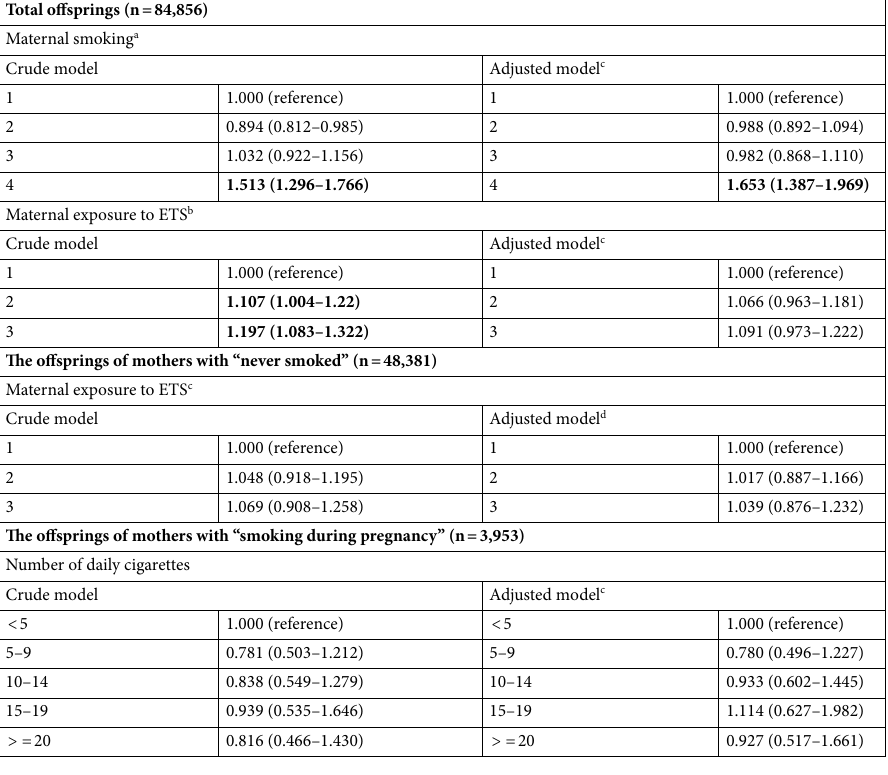
Table 2. Binominal logistic regression analysis of maternal smoking and maternal exposure to ETS for predicting offspring’s smaller circumference. Binominal logistic regression analysis was constructed to evaluate parental smoking for predicting their offspring’s smaller head circumference (HC) (small HC was defined as less than three percentile for their gestational age and sex) in the total offsprings (n = 84,856), in the offsprings of mothers with “never smoked” (n = 48,381), and in the offsprings of mothers with “smoking during pregnancy” (n = 3,953). The values are shown as odds ratios (95% confidence interval). Bold, increasing or decreasing tendency of offspring’s smaller head circumference risk. a 1 = never smoked, 2 = quit before pregnancy, 3 = quit during pregnancy, 4 = smoking during pregnancy. b 1 = seldom, 2 = 1–3 times a week, 3 = 4–7 times a week. c Adjusted for maternal age, height, pre-pregnancy BMI and parity, maternal alcohol drinking during first to third trimesters, placental weight ratio, and gestational age.